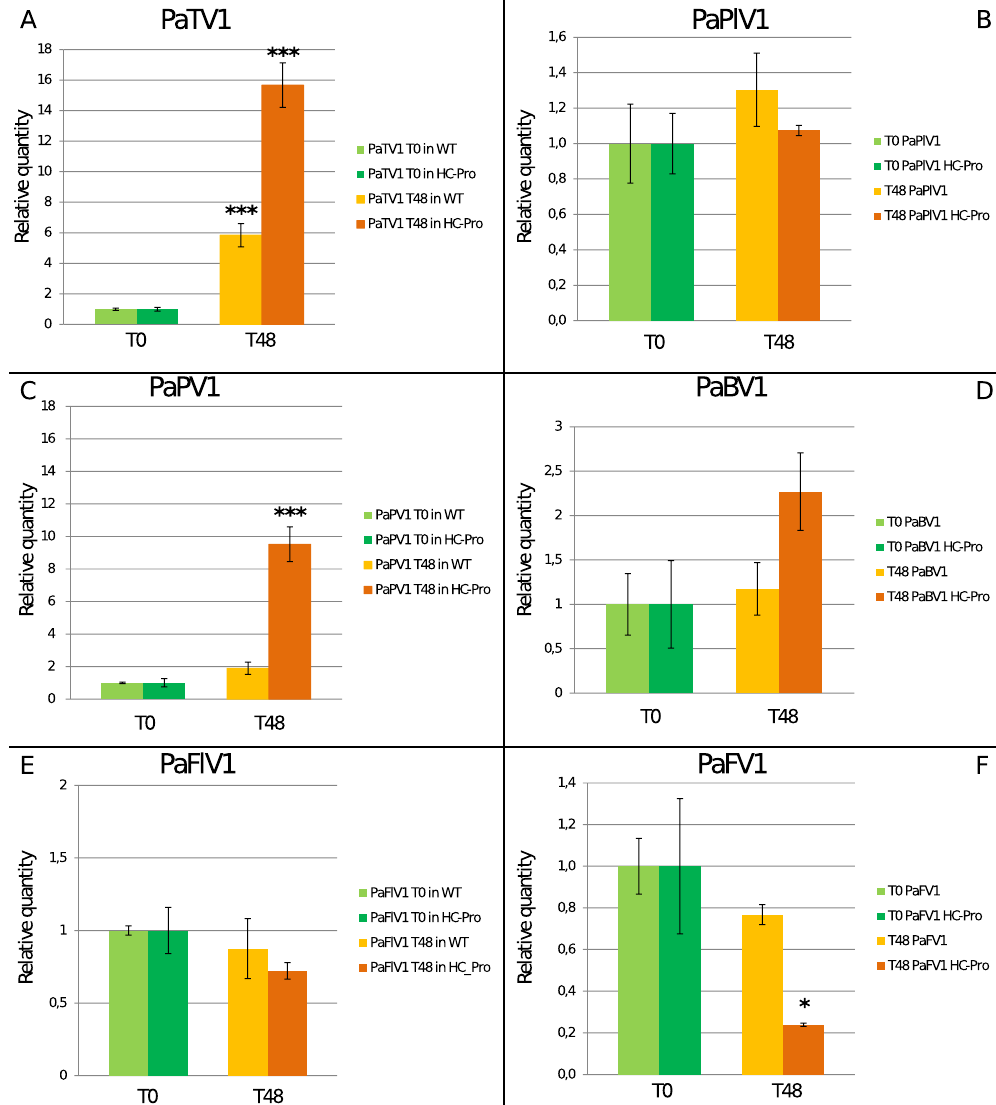
Figure 2. Comparison of virus accumulation in protoplasts from wild type (WT) and HC-Pro Nicotiana benthamiana . Quantitative Reverse transcriptase PCR (qRT-PCR) data from WT and HC-Pro N. benthamiana protoplasts were used to calculate fold change of viral RNAs at T0 and T48 time points. In panels A data for the Totivirus Penicillium aurantiogriseum totivirus 1 (PaTV1) are reported: for WT protoplasts we observed ca. 5 times more RNA at T48 (yellow bar) time point and ca. 15 times more RNA in HC-Pro protoplasts (orange bar). In panels C quantification of the Partitivirus Penicillium aurantiogriseum partitivirus 1 (PaPV1): no statistically significant differences were observed for WT protoplasts, but ca. 10 times more viral RNA was observed in case of HC-Pro protoplasts. Panels B, D, E and F show data for the other viruses: none of them displays a statistically significant increase in virus RNA load. * P < 0.05 ** P < 0.01 and *** P <